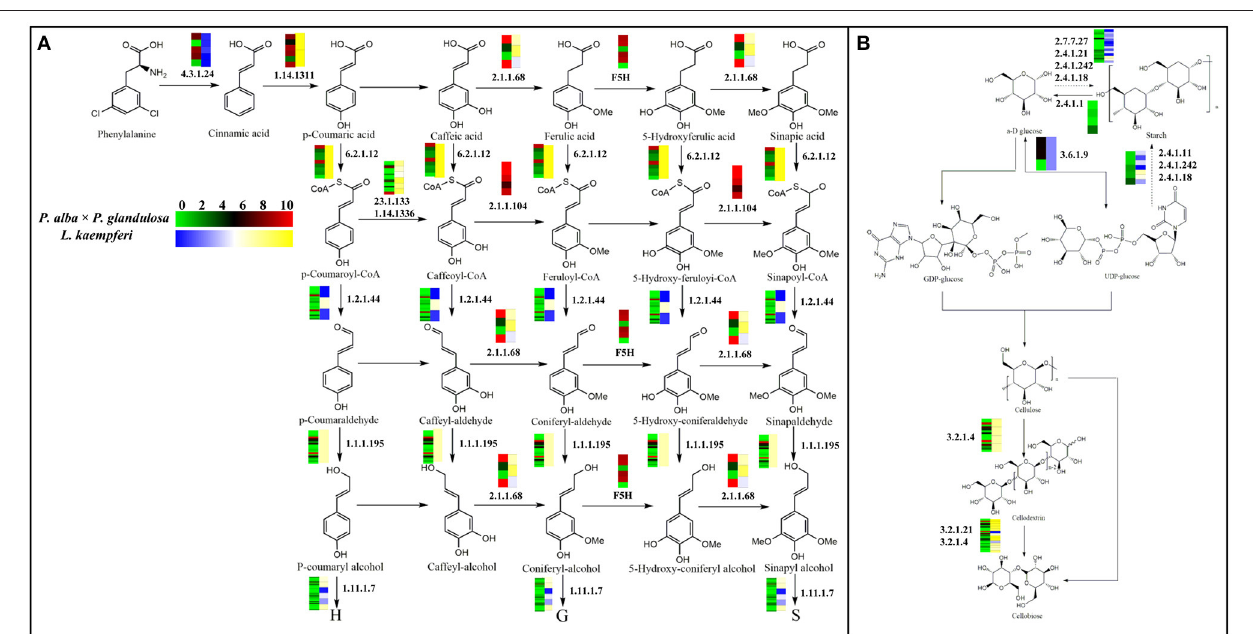
FIGURE 4 | Gene expression model for the lignin and cellulose biosynthesis pathway. (A) Branch of phenylpropanoid biosynthesis pathway that is related to lignin biosynthesis. (B) Branch of starch and sucrose metabolism pathway that is related to cellulose biosynthesis. The heatmaps in each pathway are visualized according to gene expression levels. In the color bar, red indicates a high expression level and green a low expression level in P. alba × P. glandulosa ; yellow corresponds to high expression level and blue a low expression level in L. kaempferi . The dotted arrows in the pathways denote an indirect linkage. The solid arrows refer to a direct relationship during compound synthesis. Numbers in the graph are EC identifier of corresponding